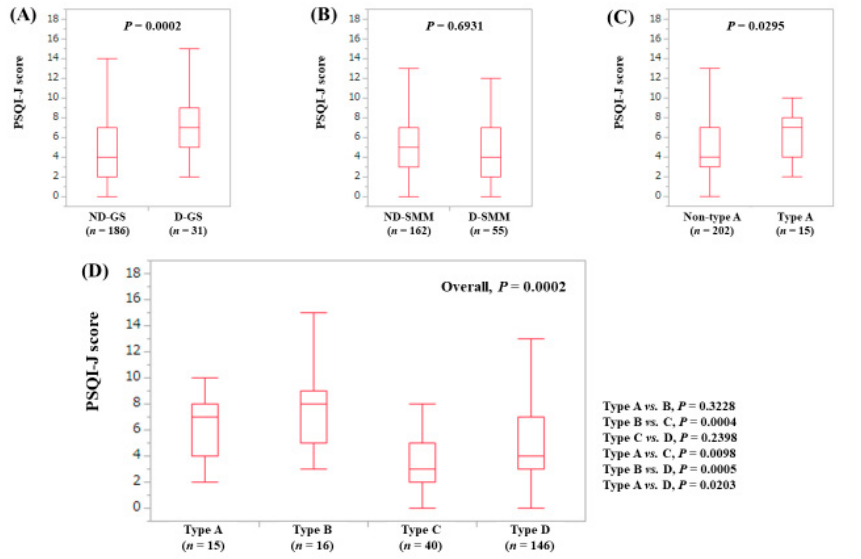
Figure 8. PSQI-J score stratified by GS and SMM for patients less than 65 years ( n = 217). ( A ) Non-decreased GS vs. decreased GS. ( B ) Non-decreased SMM vs. decreased SMM. ( C ) Non-type A